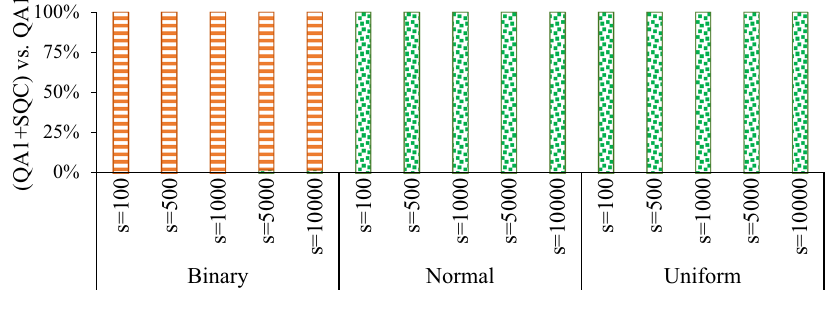
Figure 1. Performance comparison between quantum annealing ( QA 1 ) and applying SQC to raw samples attained by quantum annealers ( QA 1 + SQC ) where s denotes the number of